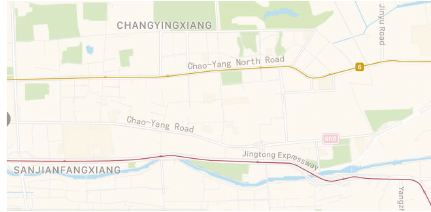
Figure 8: Five square kilometers of Jing-Tong